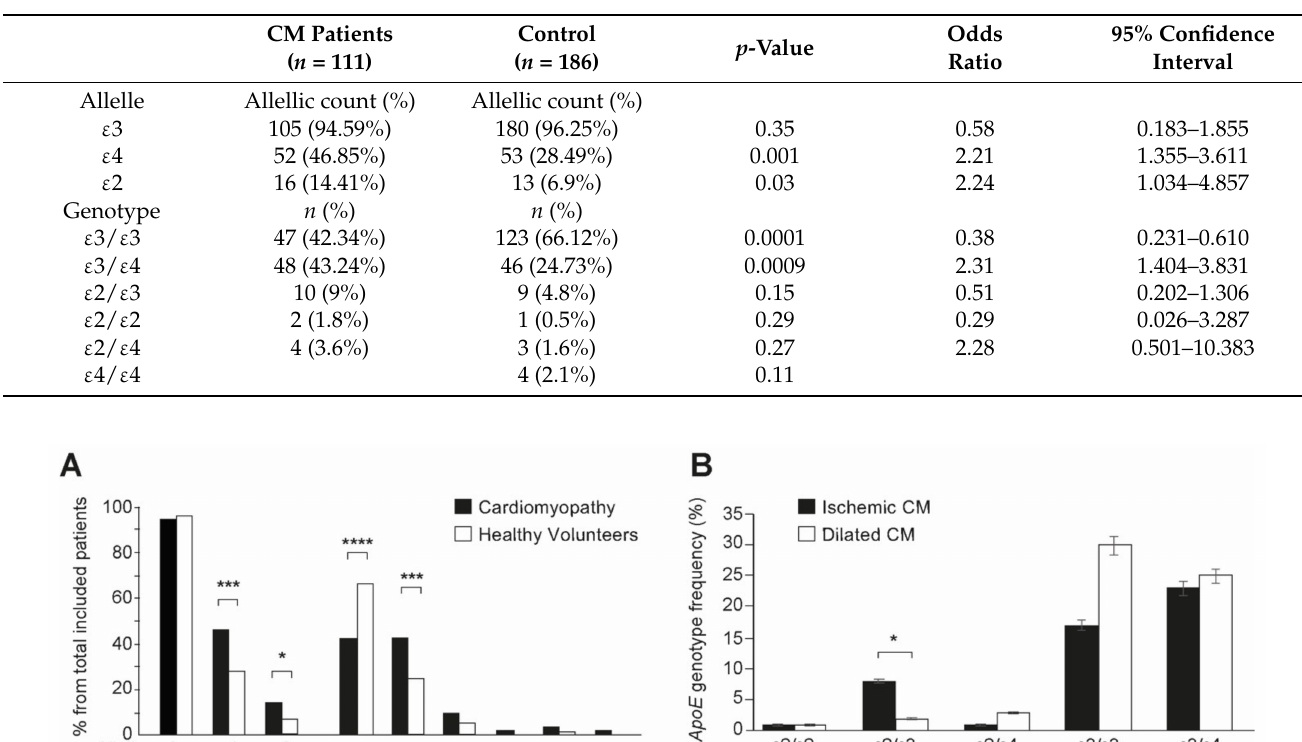
Table 2. The apoE genotype in CM patients and control group.